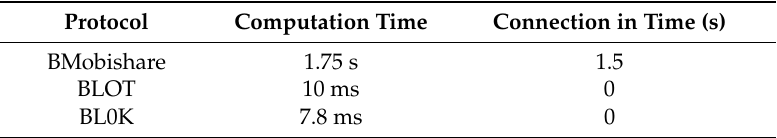
Table 4. Computation performance